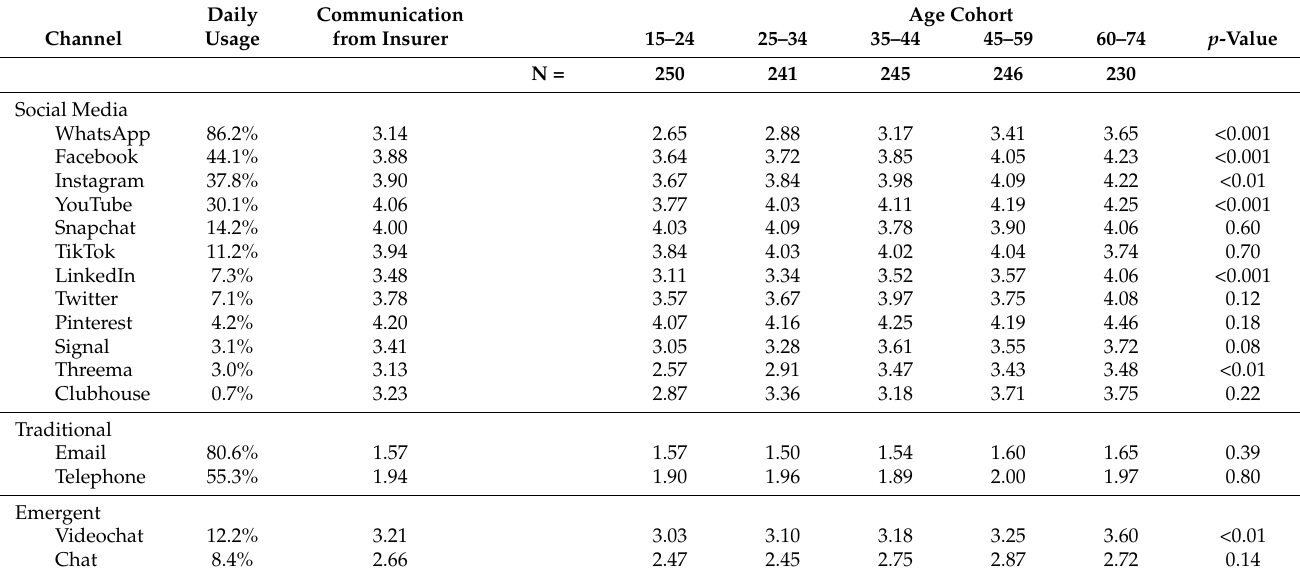
Table 2. Opinion on communication from insurers by channel (1 = very good, 5 = not good at all).